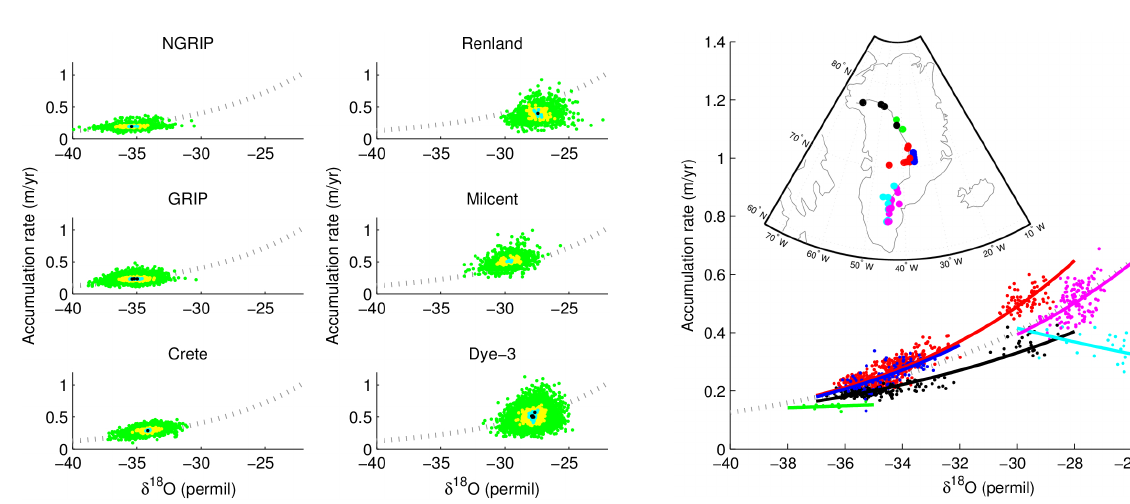
Fig. 3. 10-yr averages of ice equivalent accumulation rate and δ 18 O from 51 locations on the Greenland ice sheet. The records have been sorted into six groups according to location: northwest (black), northeast (green), central west (red), central east (blue), southwest (cyan), and southeast (magenta). The least squares exponential fits to the data for each of the groups are shown in the corresponding colour and the relation from Dahl-Jensen et al. (1993) is shown for comparison (dotted grey curve). The insert shows the 51 ice core locations with colours indicating the grouping of the records. For Dye-3, data is only shown for the last 300yr as the thickness of layers older than this are affected by upstream